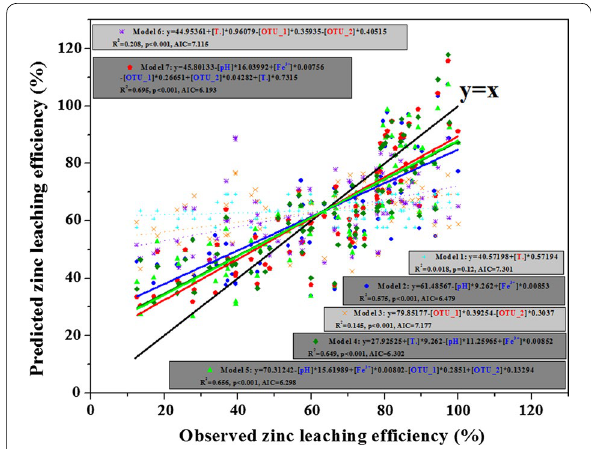
Fig. 6 Models to predict zinc leaching efficiency using multiple linear regression analysis. The variable parameters were temperature, the concentration of ferric iron, pH value, OTU_1 (98% similarity to S. thermotolerans Kr1) or OTU_2 (98% similarity to A. caldus KU)